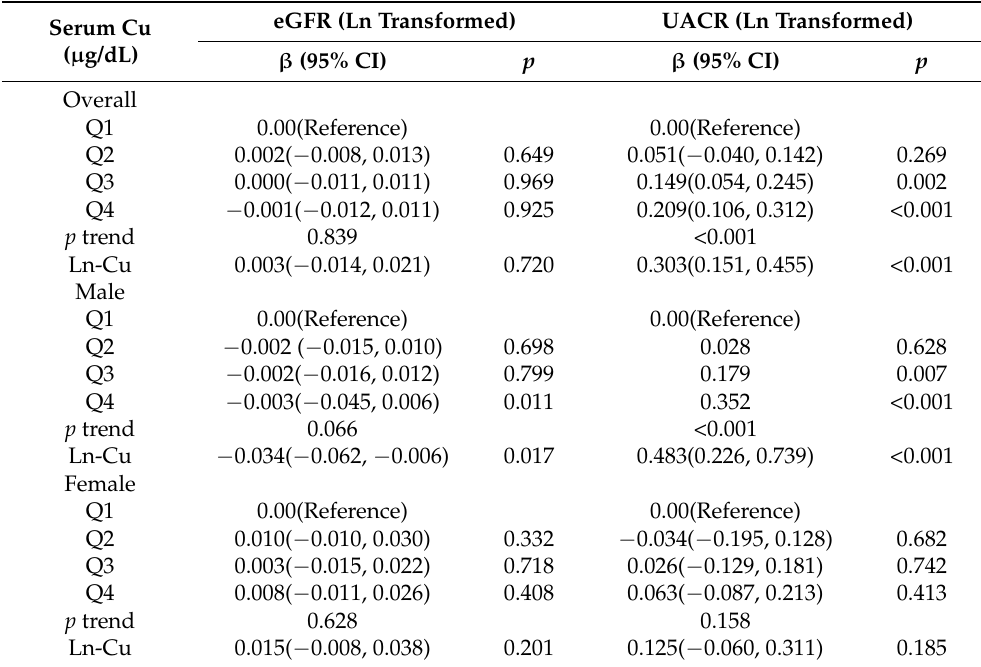
Figure A1. Flow chart of sample selection. Table A1. Sensitivity analyses for the association of serum Cu with kidney function indicators after further adjusting for serum